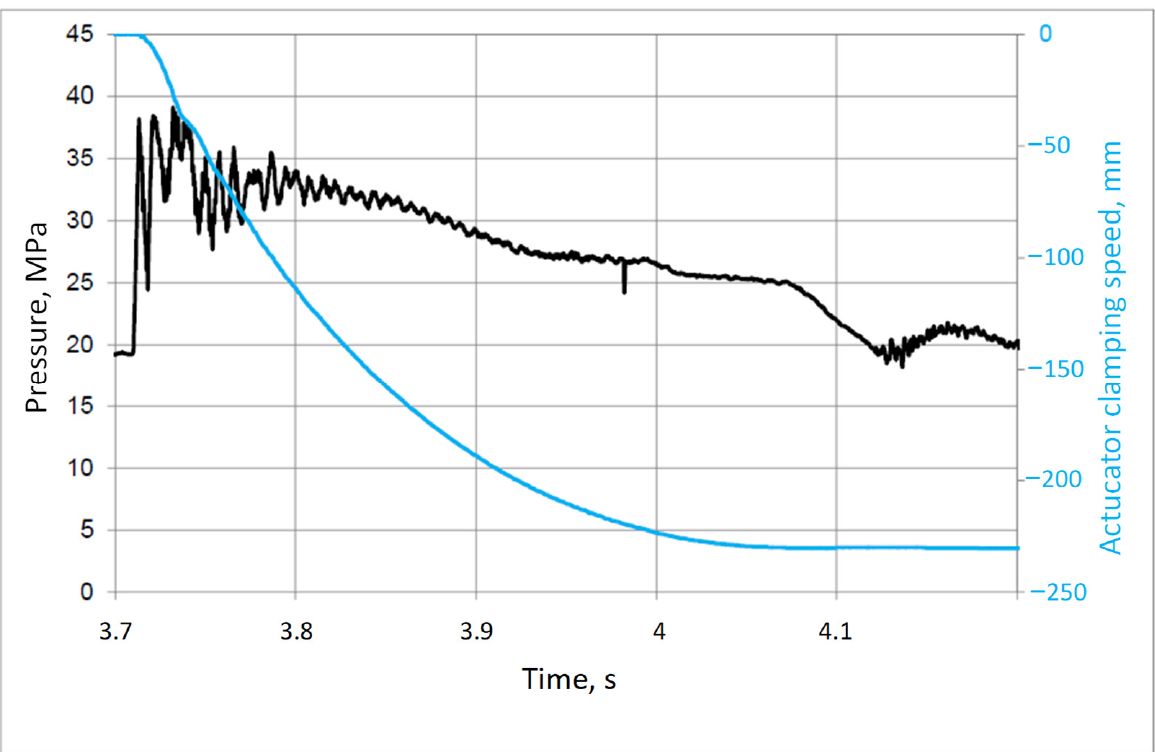
Figure 6. Recorded pressure waveform on valve input P(t) and retraction of the hydraulic cylinder piston rod l(t).